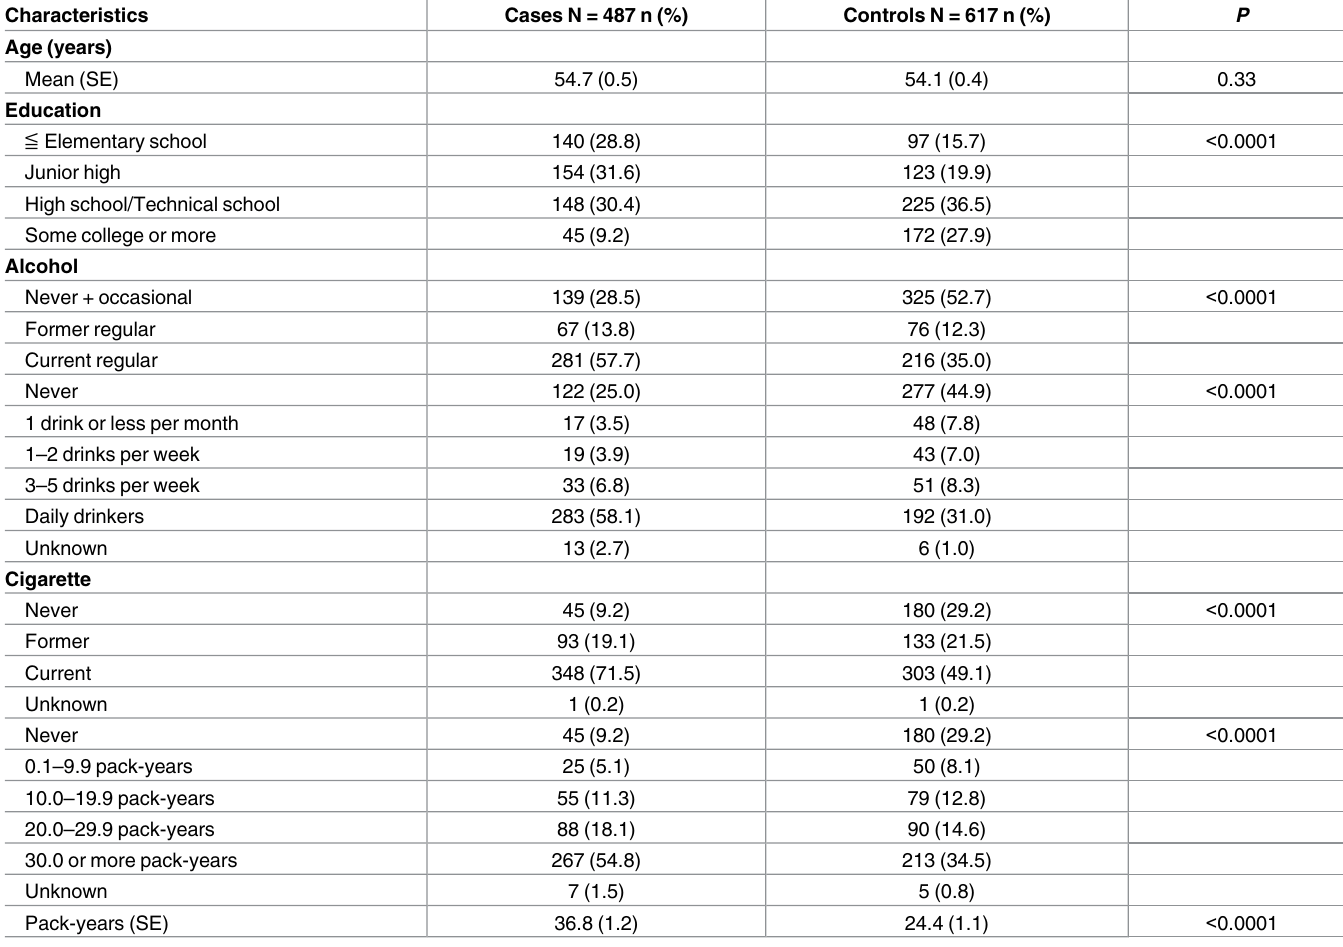
Table 1. Demographic and lifestyle characteristics of the head and neck cancer patients and control subjects.